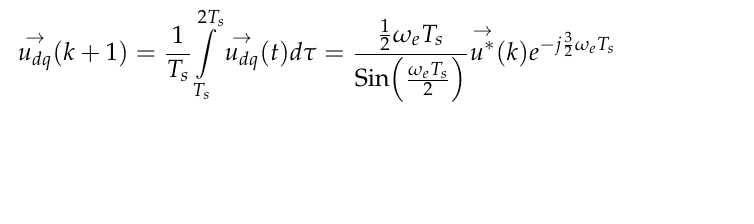
where e − j θ ( k ) − j ω e t and e j θ ( k ) denote Park’s transformation factor and inverse Park’s trans- → ( k ) denotes the voltage command value. The average output voltage u ∗ formation factor. dq is given in